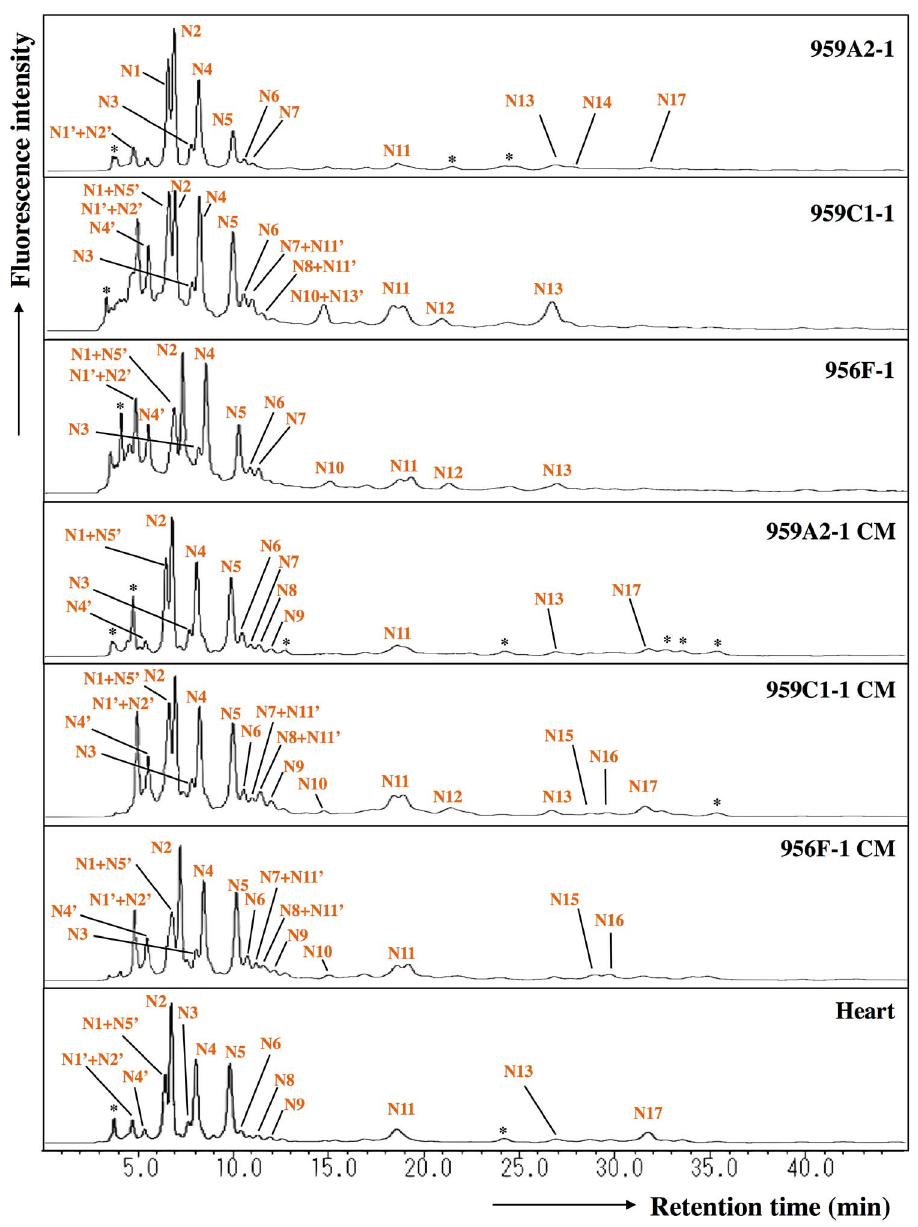
Figure 5. Reverse-phase ODS elution profiles of the neutral PA-glycans. The neutral fractions were individually applied to the ODS column and eluted according to their hydrophobicity. N1 9 , N2 9 , N4 9 , N5 9 and N11 9 : epimerization of N1, N2, N4, N5 and N11. *Fractions containing no detectable PA-oligosaccharides. doi:10.1371/journal.pone.0111064.g005 the 959A2-1 CMs, 92% of the 959C1-1 CMs and 90% of the